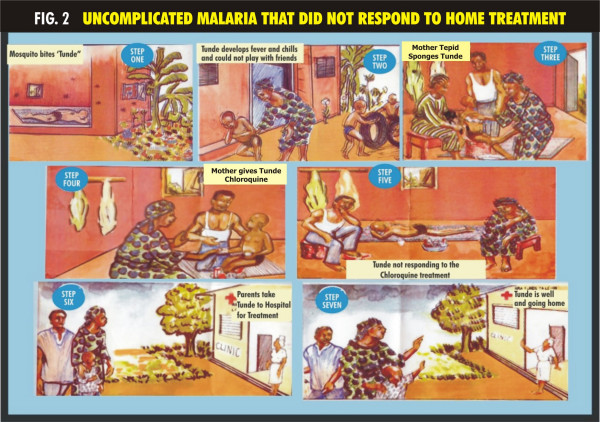
Uncomplicated malaria that did not respond to home treatment. -Scenario showing the presentation and management of uncomplicated malaria that did not respond to home treatment.